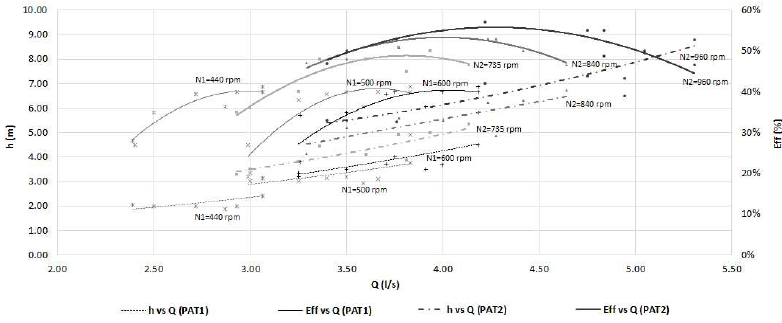
Figure 11. Performance of PATs working in parallel (PAT1 and PAT2) mode.